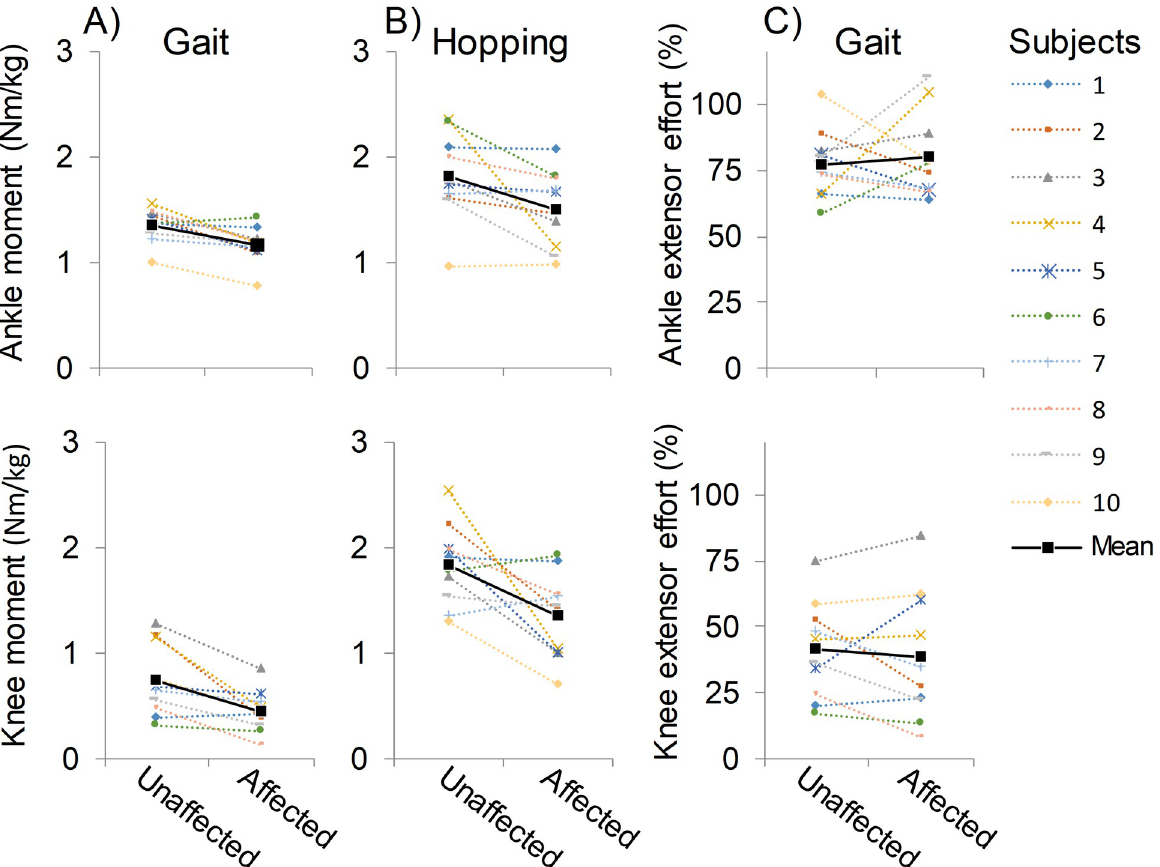
Fig 2. Individual peak joint moments during A) gait and B) hopping test, and C) relative muscle efforts during